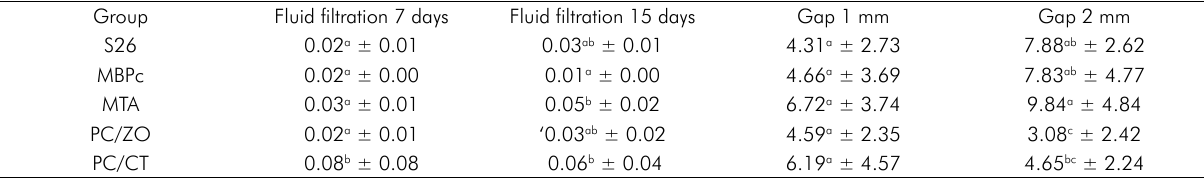
Table 1. The mean and standard deviation of fluid filtration rate (μL/min−1) and the percentages of gaps in the root-end fillings at 1 and 2 mm from the apex. Different letter in each column indicate statistically significant differences (p < 0.05)